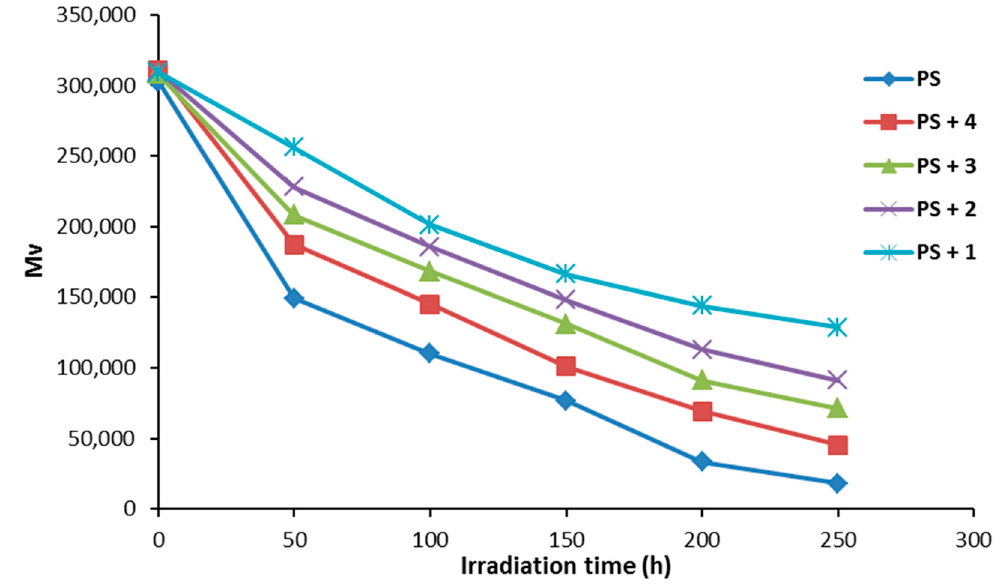
Figure 7. The effect of irradiation on the viscosity average molecular weight for PS films.